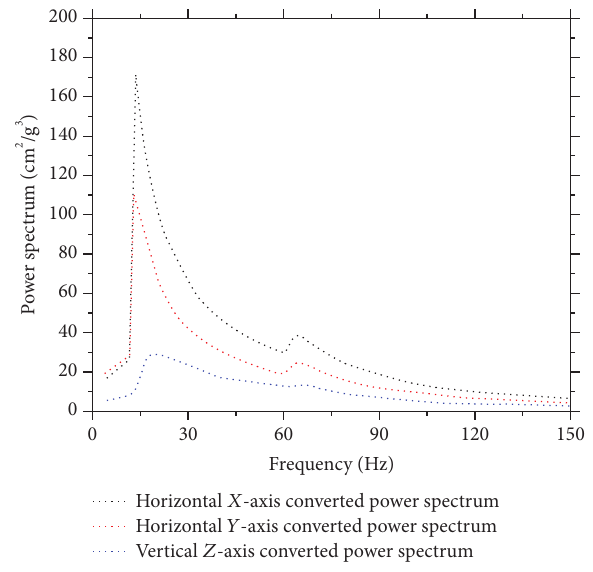
Figure 1: Converted power